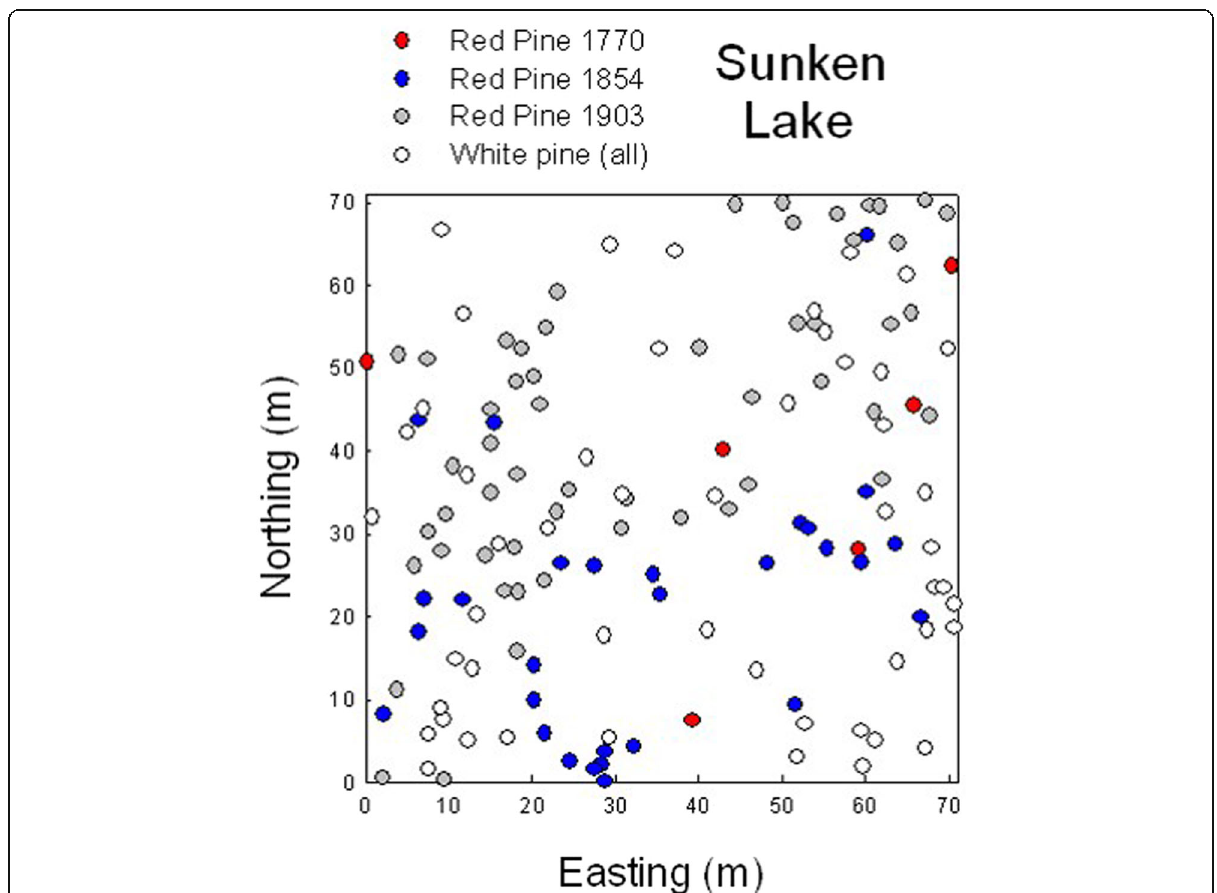
Fig. 4 Stem map of trees in the Sunken Lake old-growth red pine-dominated stand in MN, USA. Red pine trees are listed according to cohort establishment dates; establishment dates for eastern white pines are pooled. Redrawn from Fraver and Palik